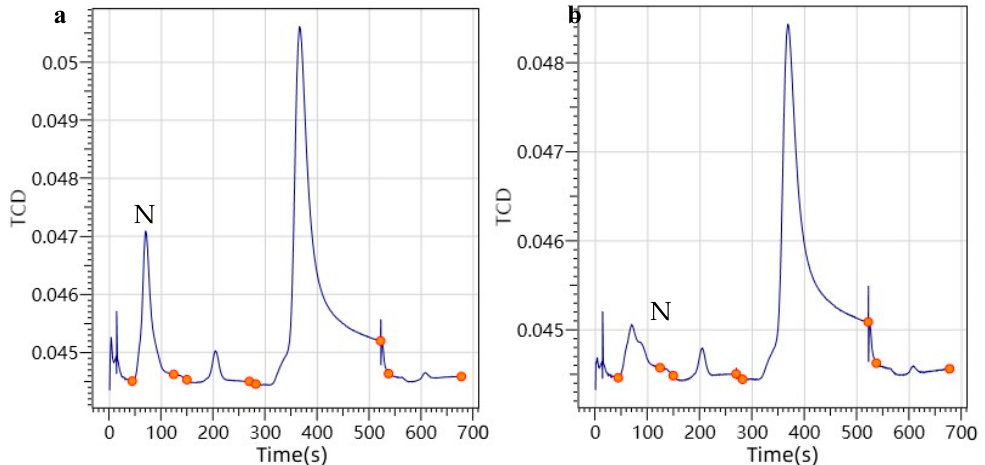
Figure 1. Blank comparison diagram of one-stage purge and two-stage purge. For Panel ( a ), under the condition of one-stage purging, the N signal is high, and the N brought from the air is not completely purged. For Panel ( b ), under the condition of two-stage purge, we can see the lowest and most stable N signal.